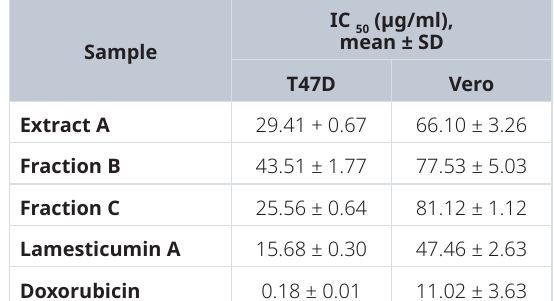
Table 2. IC values of extract, fractions and isolated 50 compound 1 against T47D breast cancer cell line and normal cell line